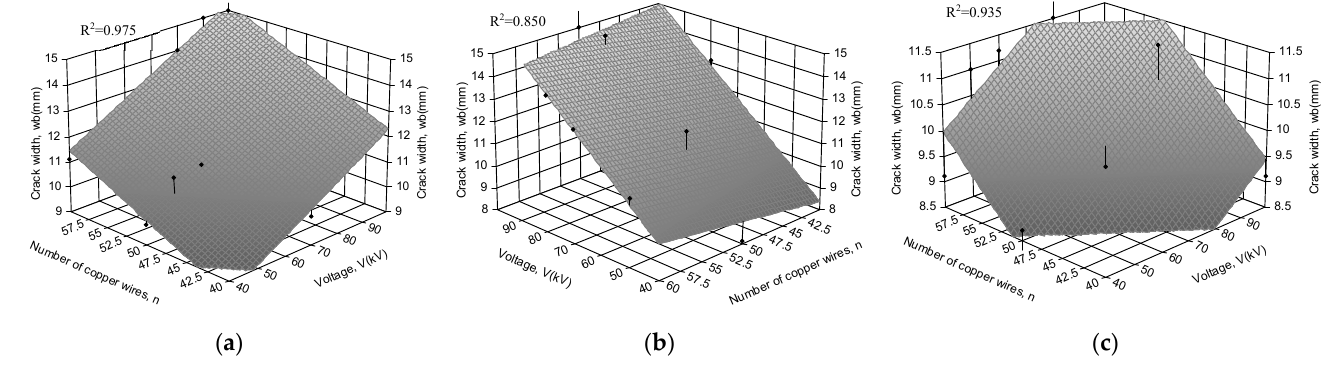
Figure 13. Fitting surface of concrete crack width with copper wire number and discharge voltage at 300 mm hole spacing. ( a ) Concrete C20; ( b ) Concrete C30; ( c ) Concrete C40.